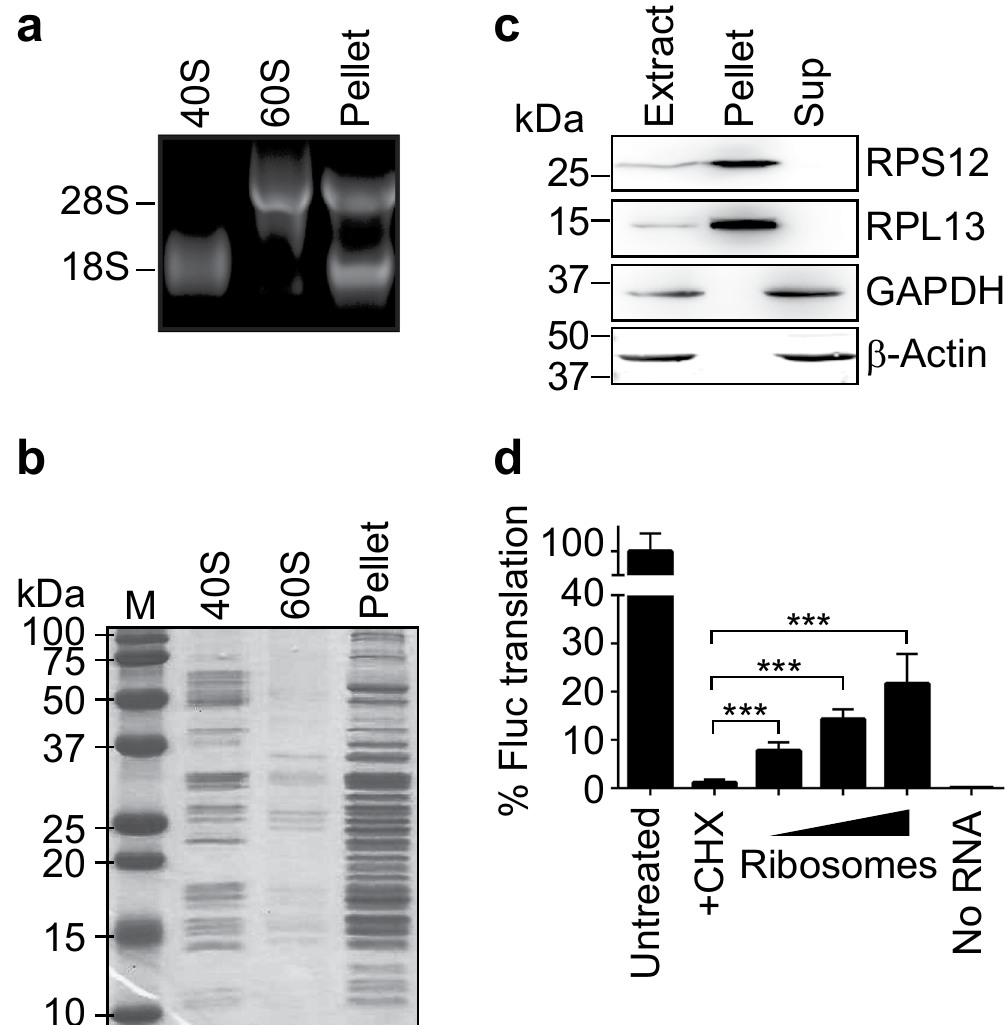
Figure 2. Preparation of translationally active ribosomal template. ( a ) RNA extracted from the purified 40S and 60S subunits and whole ribosome pellet were separated on an agarose gel; the position of 28S and 18S rRNA are indicated. ( b ) Colloidal coomassie stained 15% PAA gel for visualisation of proteins contained in the ribosome pellet and purified 40S and 60S ribosomal subunits. A marker (M) with molecular weights in kilodaltons (kDa) is shown to the left. ( c ) Immunoblot analysis with specific antibodies detecting RPS12, RPL13 (RPs as positive control), GAPDH and β -actin (non-RPs as negative control). Lanes refer to the following: Extract, total cytoplasmic extract; Pellet, ribosome pellet; Sup, supernatant of the ribosome pellet. Images of uncropped gels and blots are shown in the Supplementary Fig. S1. ( d ) In vitro translation assays in rabbit reticulocyte lysate. CHX was added to lysates to inhibit translational activity, followed by supplementation of the lysate with increasing amounts of purified human ribosomes (2 μ g, 4 μ g, and 8 μ g). Height of the bars indicates relative bioluminescence of translated firefly Luc protein (Fluc) compared to untreated lysates (100%). A sample without RNA (No RNA) was added as a control to measure background bioluminescence of untreated lysates. Error bars represent standard deviation (SD), n = 3. *** P < 0.005, two-tailed student’s t -test with equal